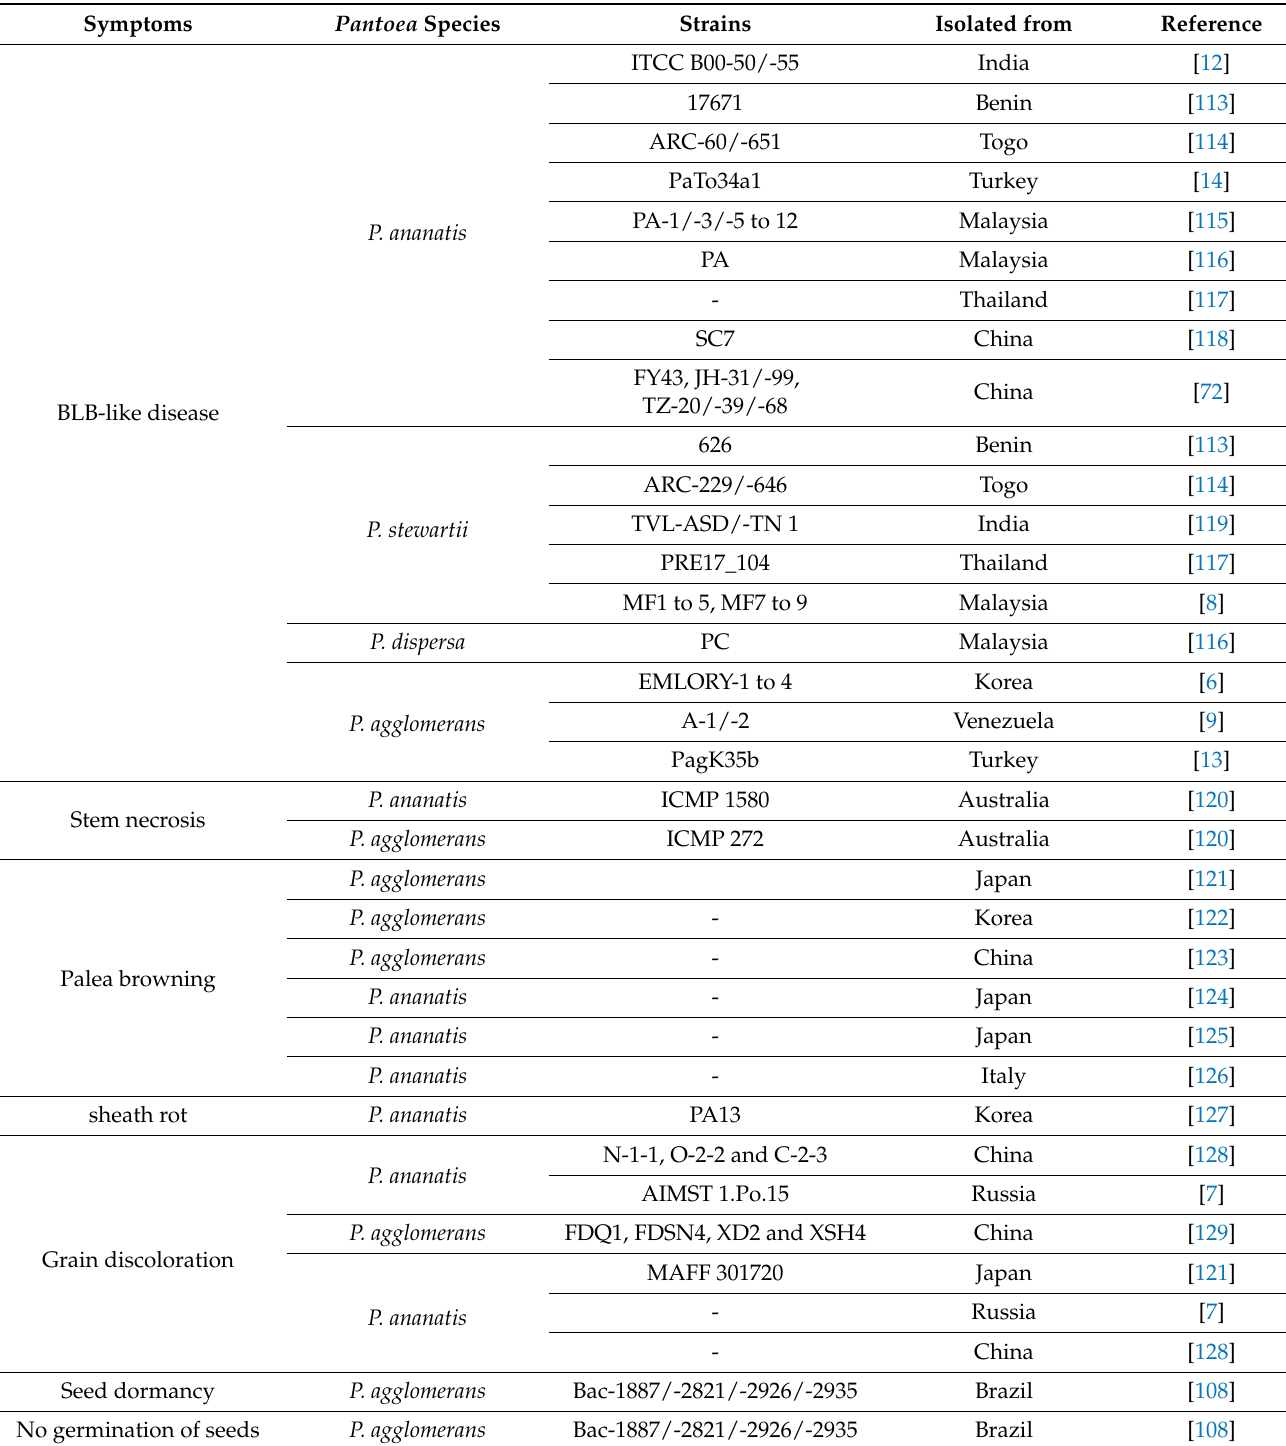
Table 3. Summary on the virulence of Pantoea to rice from reported